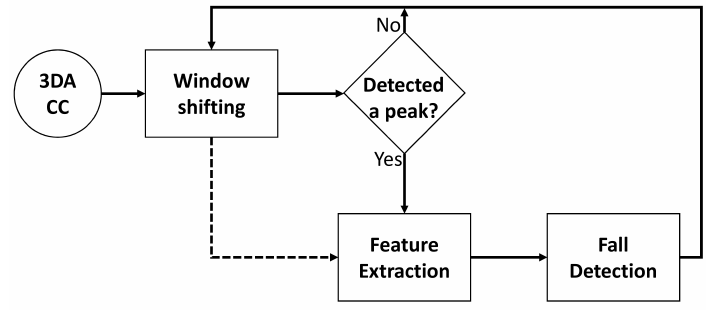
Figure 1. Block diagram of the solution.